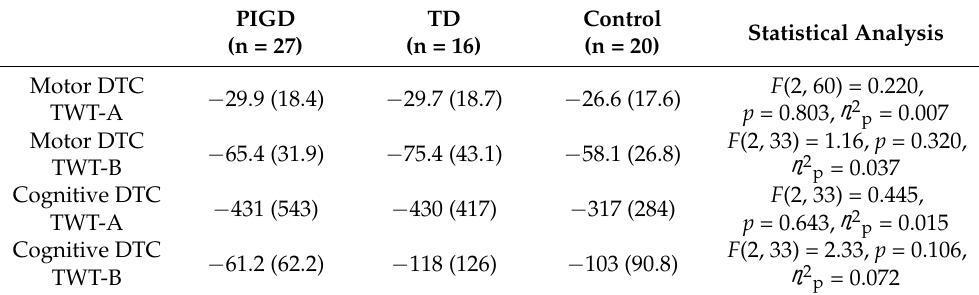
Table 5. Mean values and standard deviation of DTC in the TWT divided into the PD phenotypes and healthy